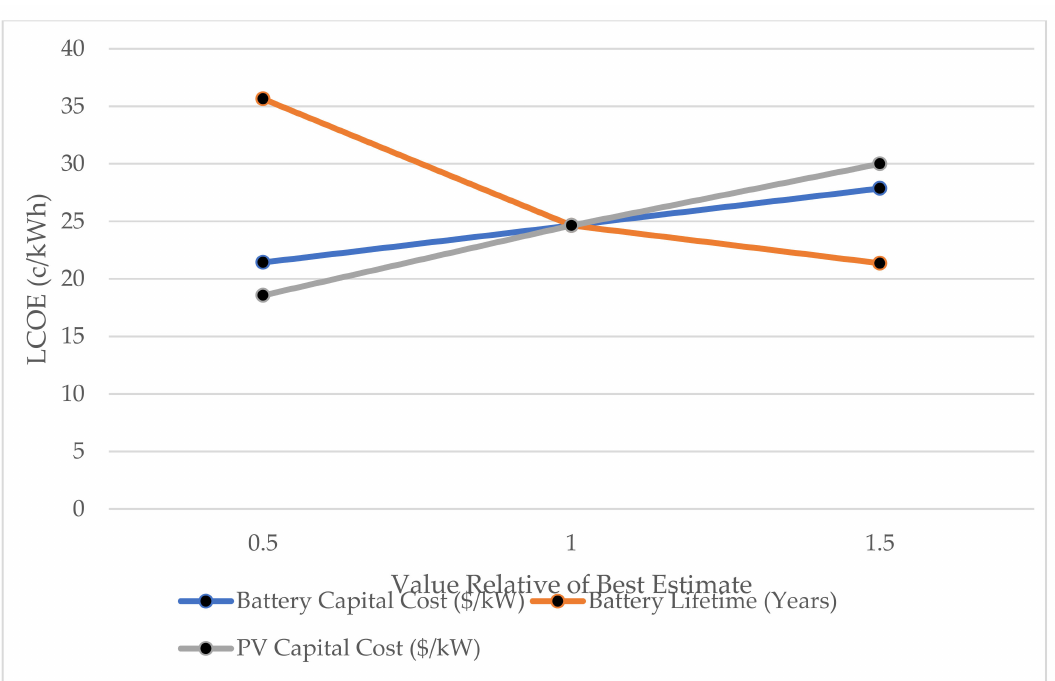
Figure 18. Sensitivity Analysis of PV